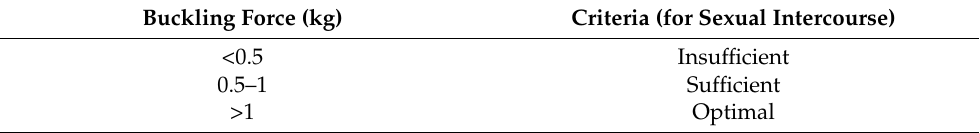
Table 1. Summary of buckling force (kg) and its corresponding criteria for sexual intercourse adapted from Virag et al.